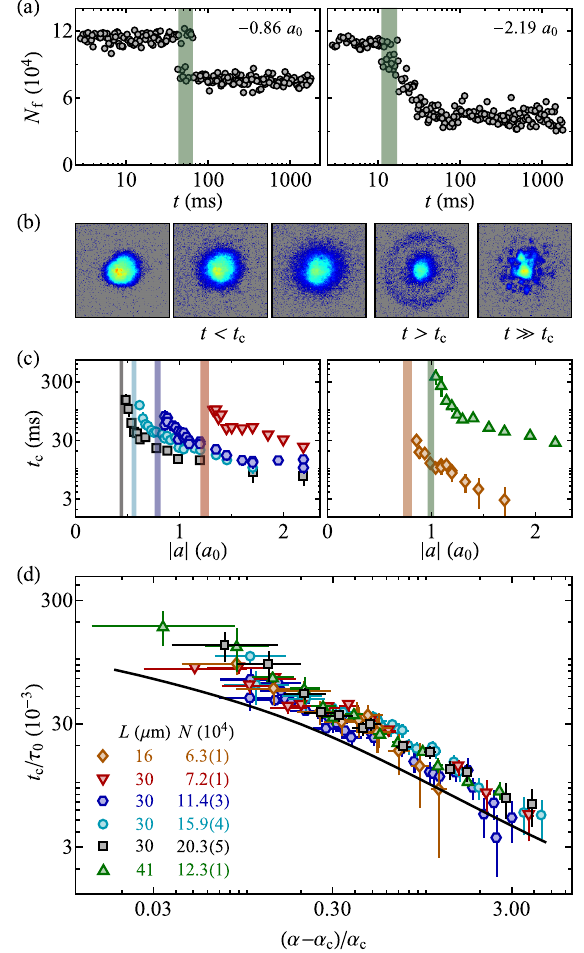
FIG. 3. Collapse dynamics. (a) Atom number versus time after quenches to a ¼ − 0 . 86 a 0 (left panel) and − 2 . 19 a 0 (right panel); here, L ¼ 30 μ m and N ¼ 11 . 4 × 10 4 , corresponding to a − 0 . 79 a t and its uncertainty. 0 . Green bands indicate c ¼ c (b) Typical ToF images at various stages after the quench (here, for a ¼ − 1 . 02 a 0 ). (c) Collapse time versus a for six data sets taken for various L and N ; see legend in (d). The shaded bands indicate a values. (d) Universal collapse dynamics. We plot the c dimensionless collapse time versus the reduced distance from the critical point, for all six data sets. The solid line shows the results of lossless GP simulations without any free